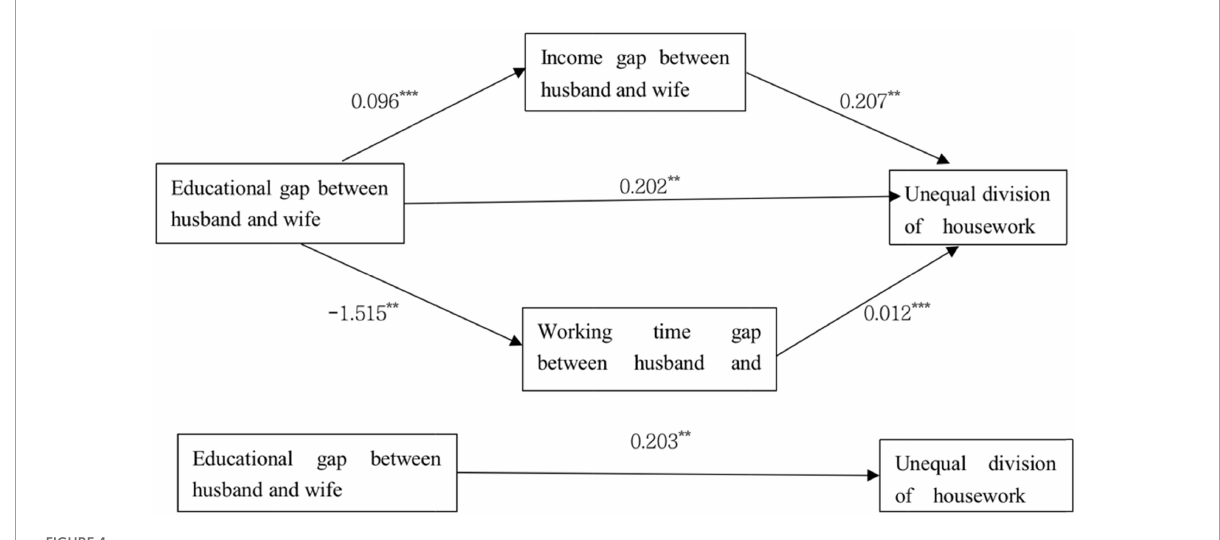
FIGURE4 Test results of parallel mediation model. ** p < 0.05; *** p <